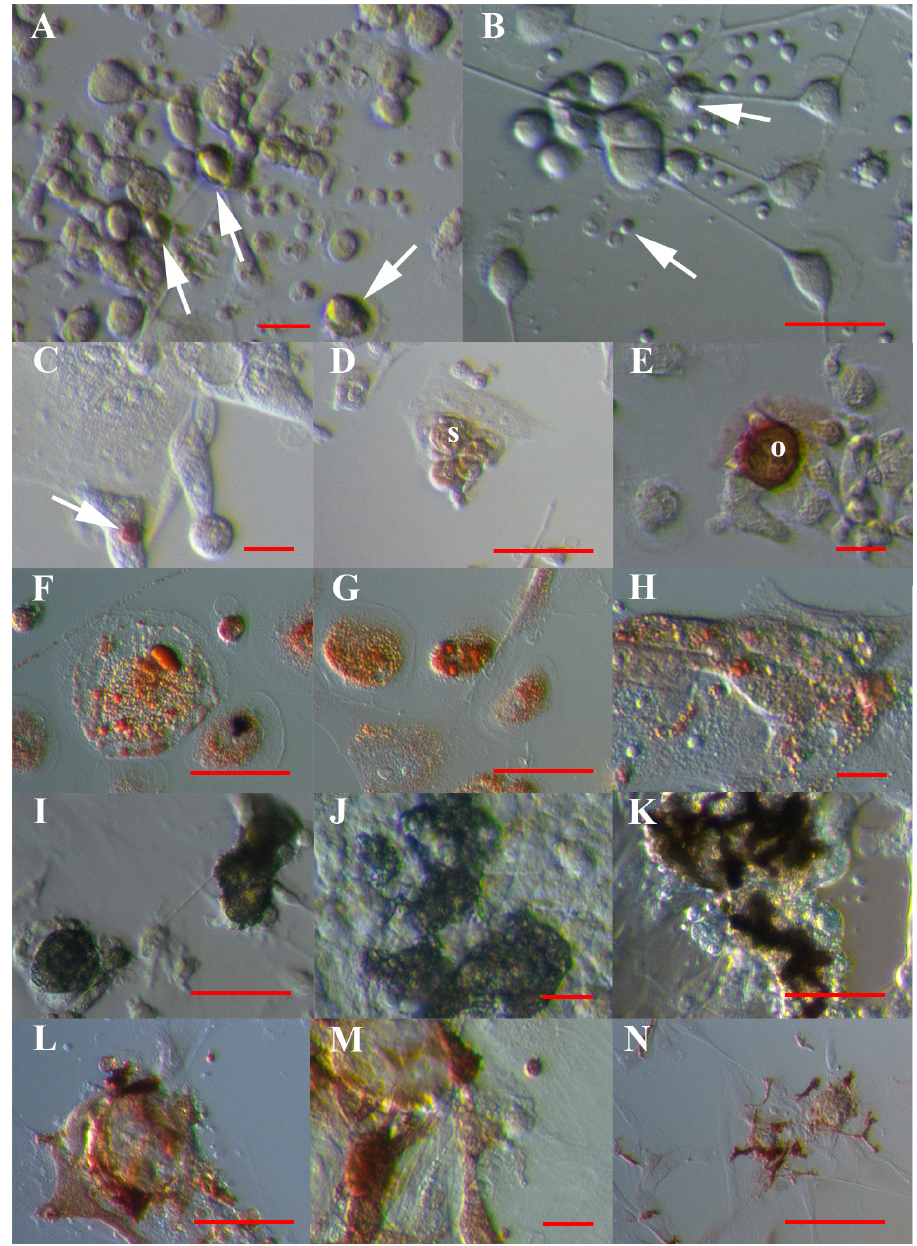
Figure 9. In vitro differentiation of VSEL-like stem cells (arrows) with diameters of up to 5 μ m sorted using MACS according to established protocols. ( A , B ) VSEL-like stem cells from recurrent ovarian cancer ascites (arrows) attached to the dish bottom, losing the yellow “shining” and spontaneously developing different phenotypes with protrusions. ( C ) VSEL-like stem cells in a hESC cell culture expressing the pluripotency-related marker SSEA-4 (brown), as revealed by the DAB procedure. ( D ) SSEA-4-positive (brown) spheroid and ( E ) SSEA-4-positive (brown) oocyte-like cells developed from small stem cells in ascites cell culture. ( F – H ) Differentiation into adipogenic lineage; lipid droplets were stained red after Oil Red O staining: normal ovary (F), ascites (G) and hESCs (H). ( I – K ) Dedifferentiation into osteogenic lineage with calcium deposits, which were stained black after von Kossa staining: normal ovary (I), ascites (J) and hESCs (K). ( L – N ) Differentiation into a neural lineage after S100 staining (brown): normal ovary (L), ascites (M) and hESCs (N). Inverted microscope (Ho ff man illumination). Legend: s—spheroid; o—oocyte-like cell. Red bar: 10 µ m for A–C, E, H, J, M; 50 µ m for D, F, G, I, K, L; 100 µ m for